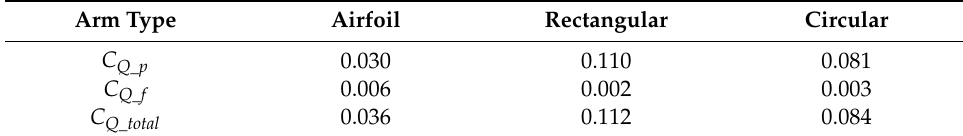
Table 8. Resistance torque coe ffi cients based on pressure, friction, and both.